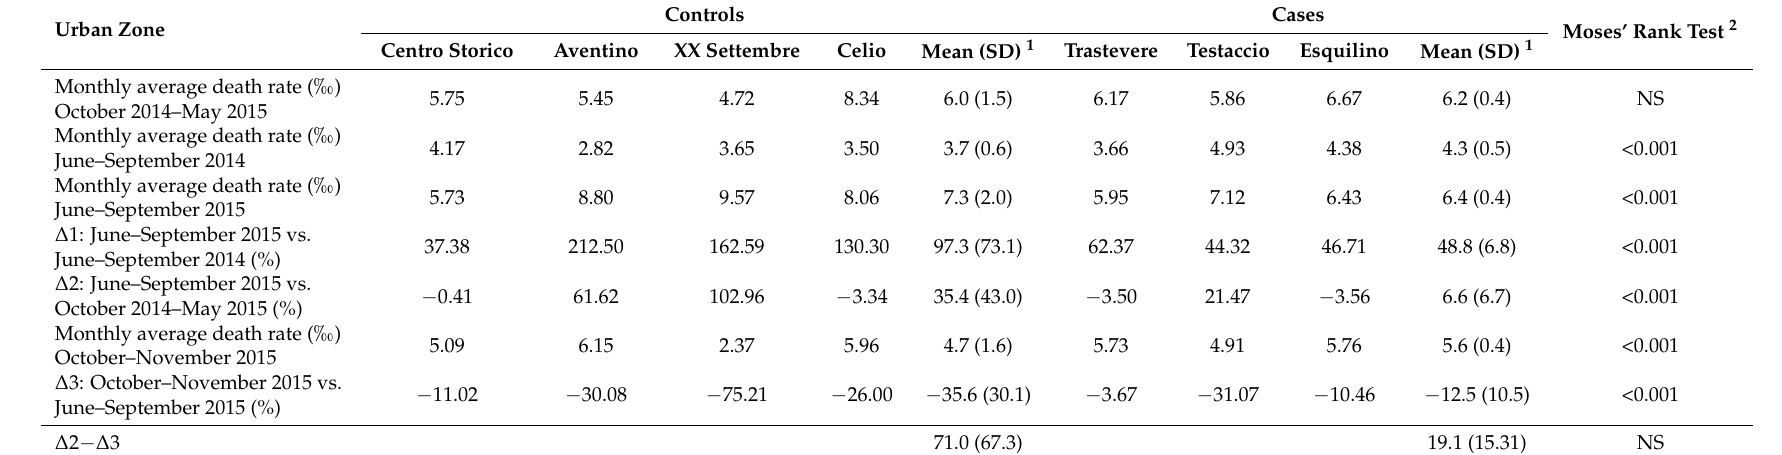
Table 2. Average death rates and percentage differences of death rates by month and calendar